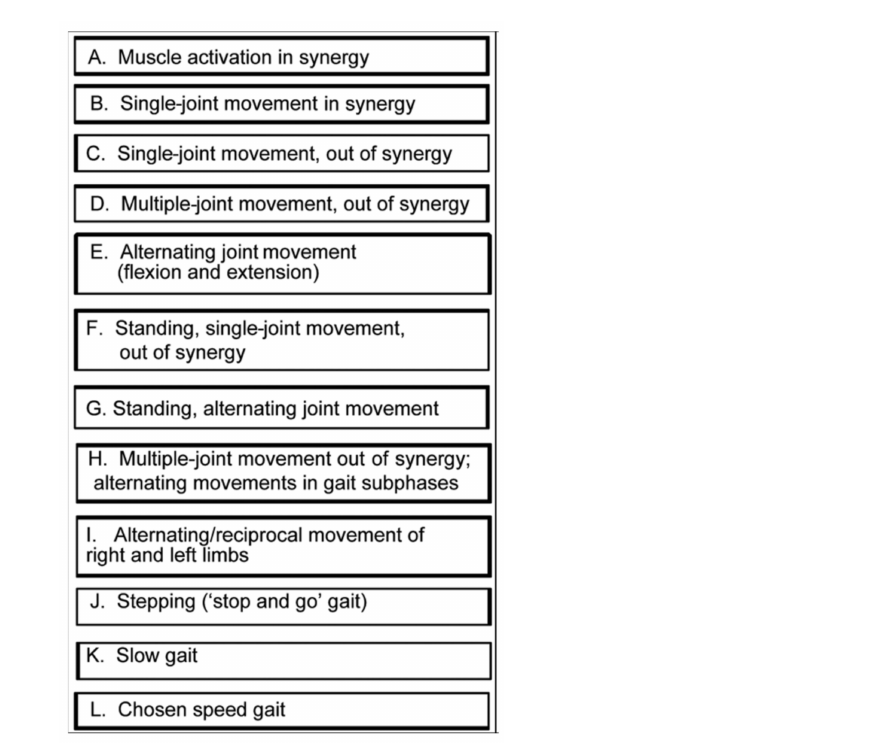
Figure 1. Motor Task Hierarchy for Limb and Gait Coordination Training (with permission, JRRD, 2012, Daly et al.